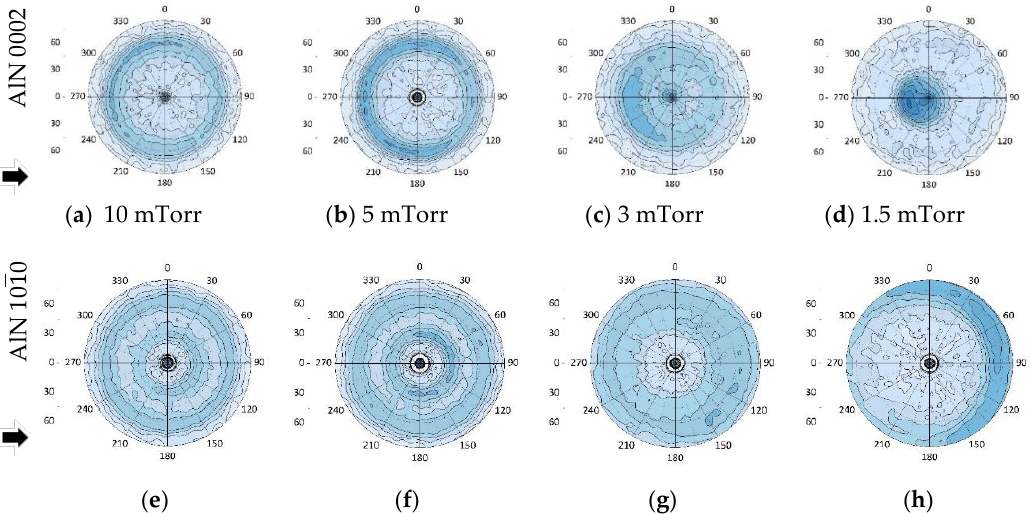
Figure 5. Pole figures for AlN 0002 ( a – d ) and 10 1 0 ( e – h ) grown with α = 0° at different working gas pressures with black arrows indicating the direction of incoming flux.